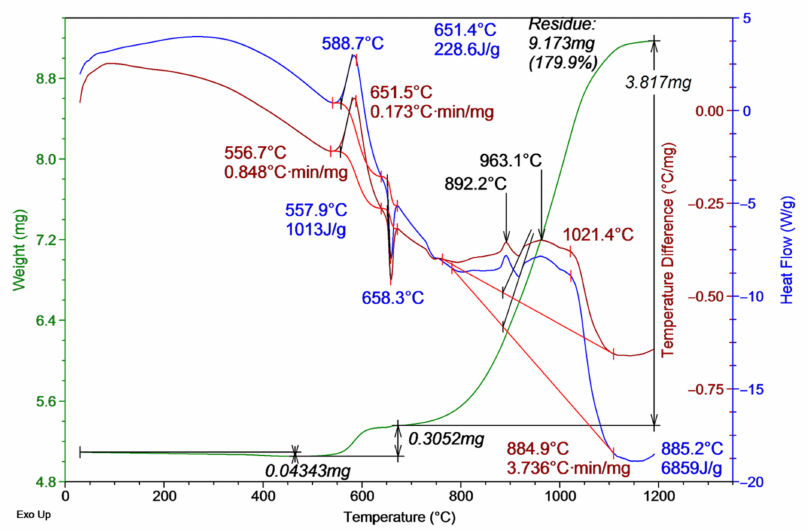
Figure 6. Thermogram of Al micropowder after exposure to microwave radiation with a pulse duration of 3 µ